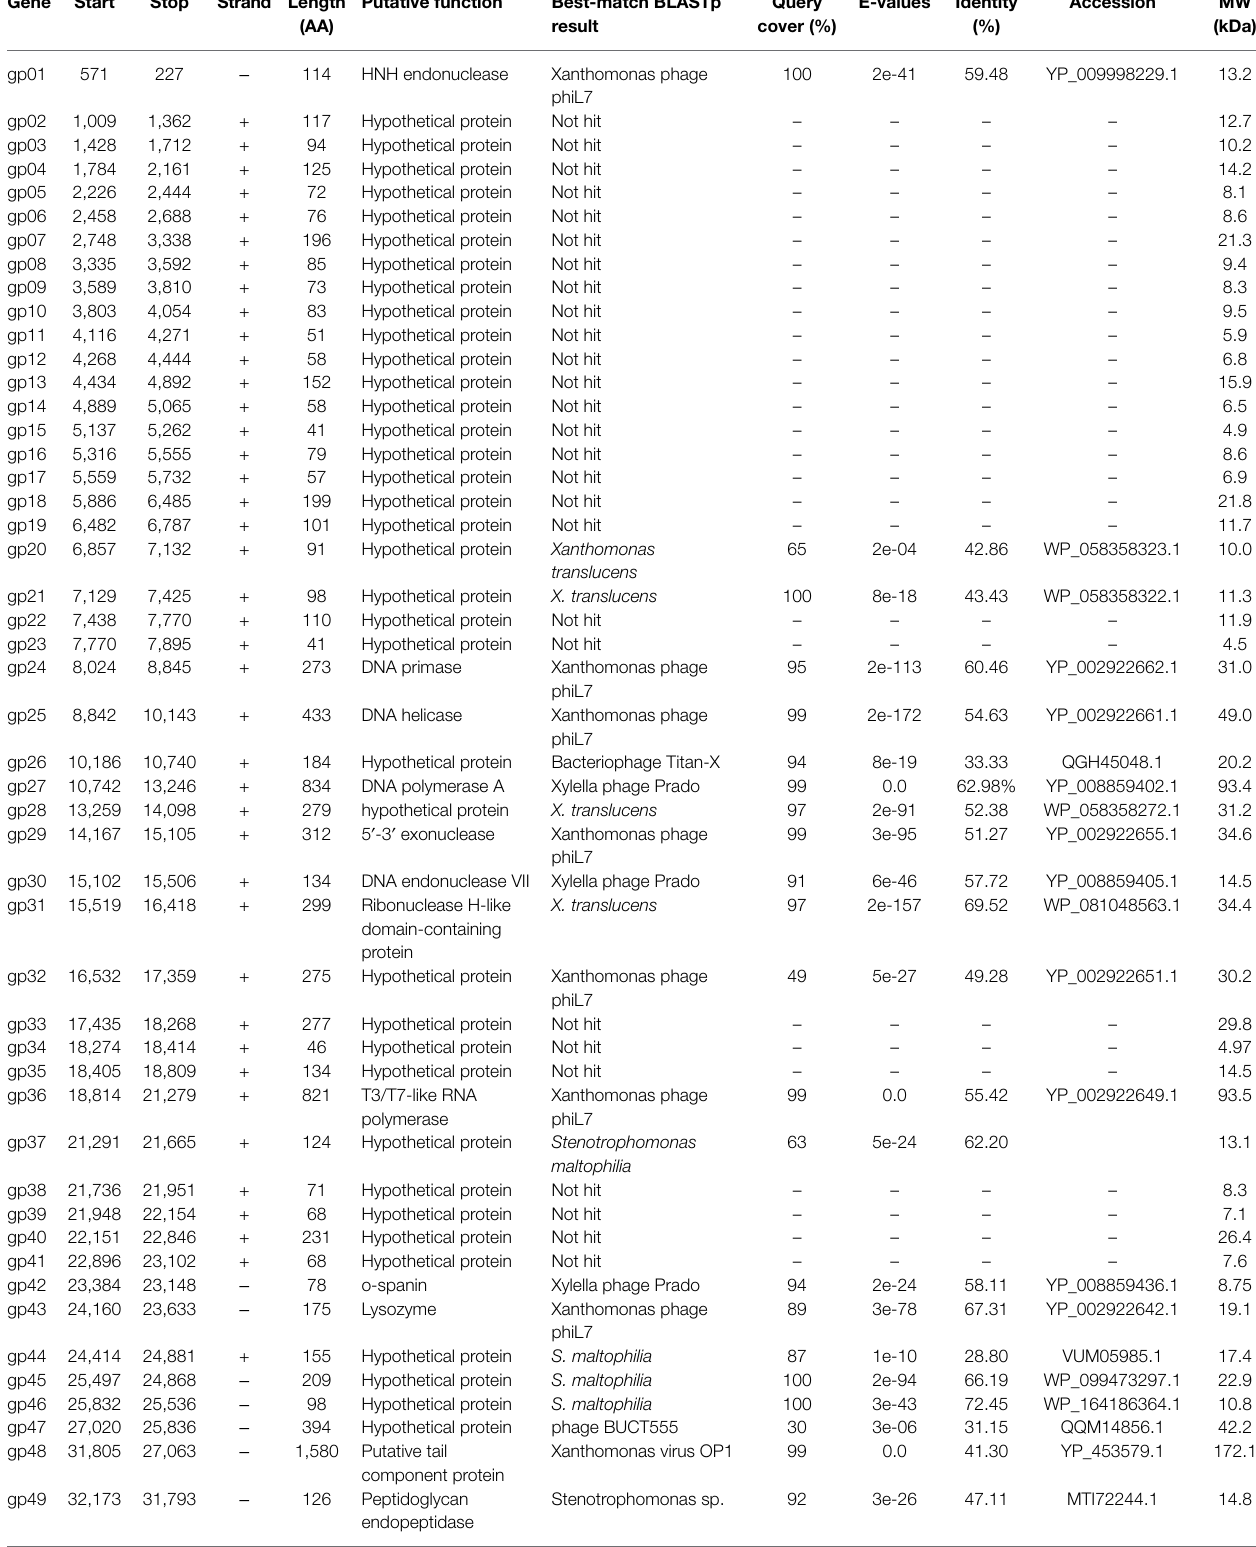
TABLE 2 | Genome annotation of bacteriophage